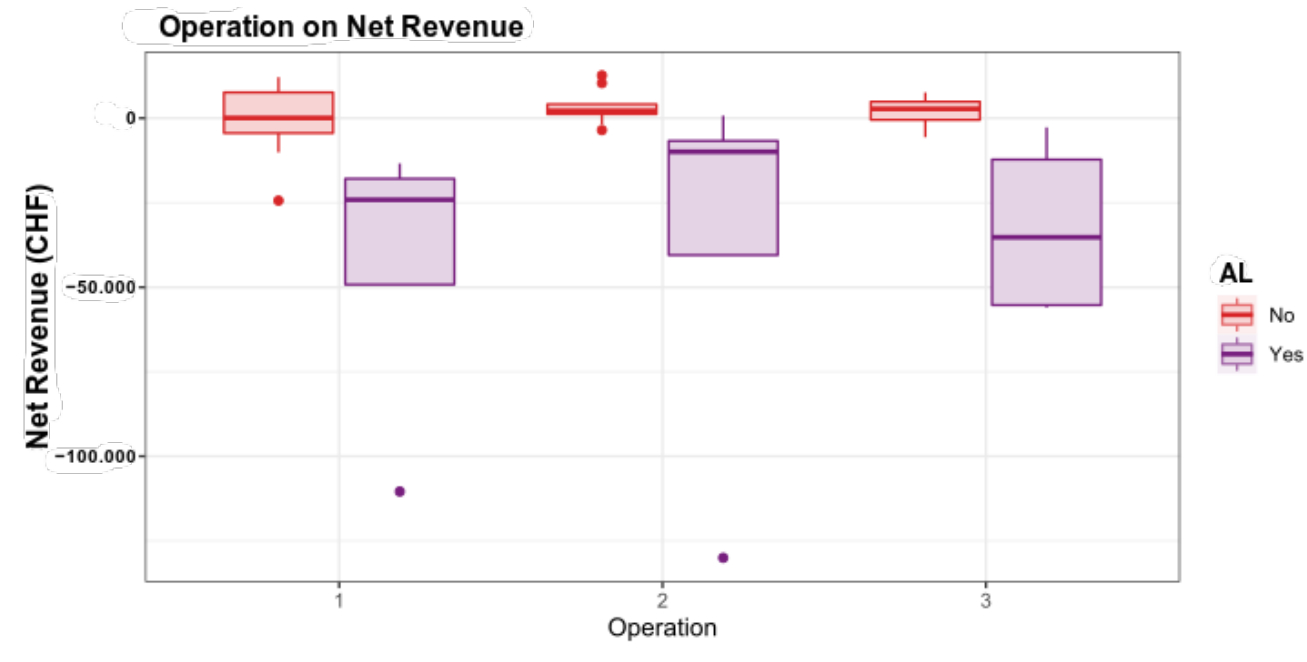
Figure 4. The influence of the operation on the result differs markedly in the two populations of patients without and those with AL. For patients without AL, almost every type of operation shows stable higher net revenue. In cases with AL, mainly hemicolectomy left, extended left and sigmoidectomy led to a high financial loss. 1, hemicolectomy left or extended hemicolectomy left; 2, hemicolectomy right or extended hemicolectomy right; 3, sigmoidectomy.